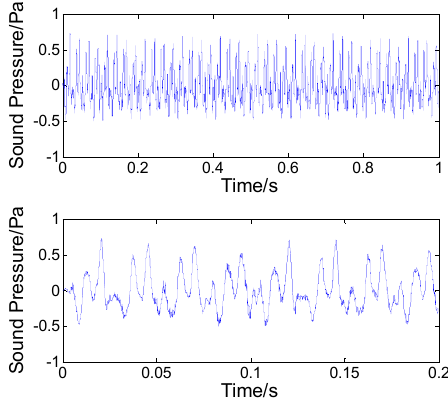
Figure 7. Sound signal for moving source.